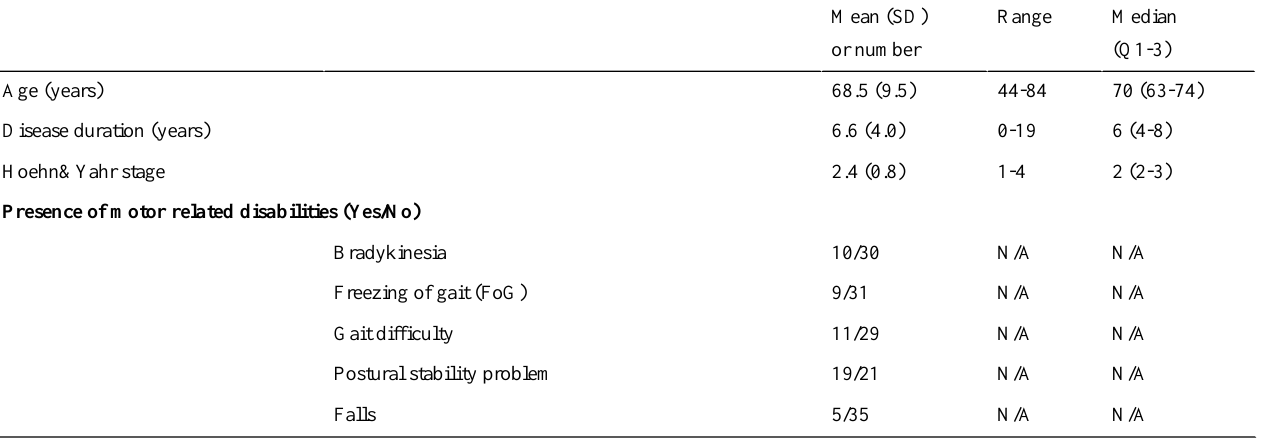
Table 4. Patients’general characteristics and UPDRS a scores